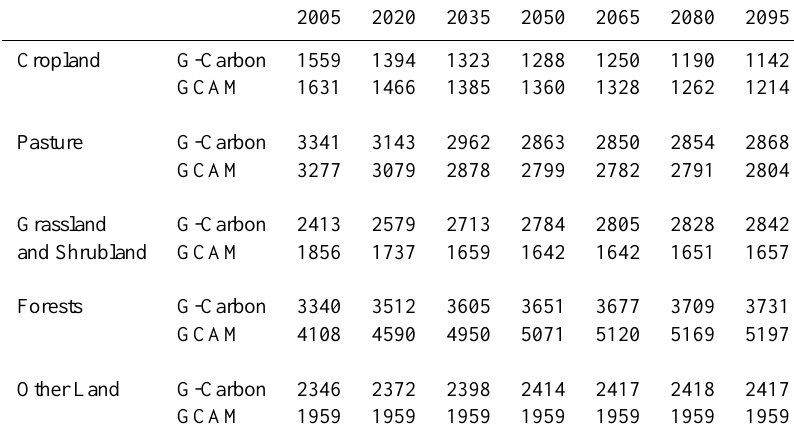
Table 7. Land areas (in million ha) in GCAM RCP4.5 and G-Carbon RCP4.5